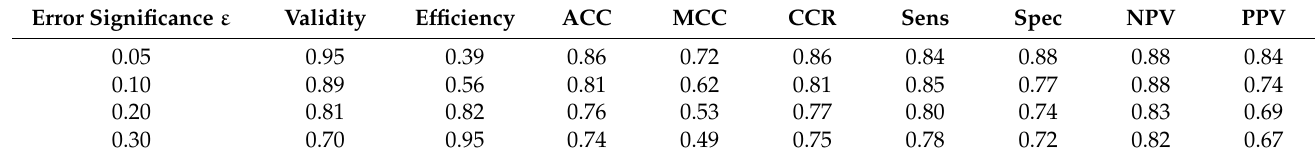
Table 3. Performance of the model based on ten selected bioactivity descriptors on the test set. Error Significance ε